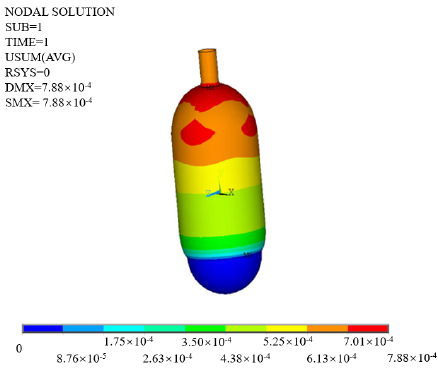
Figure 4. Displacement cloud diagram.